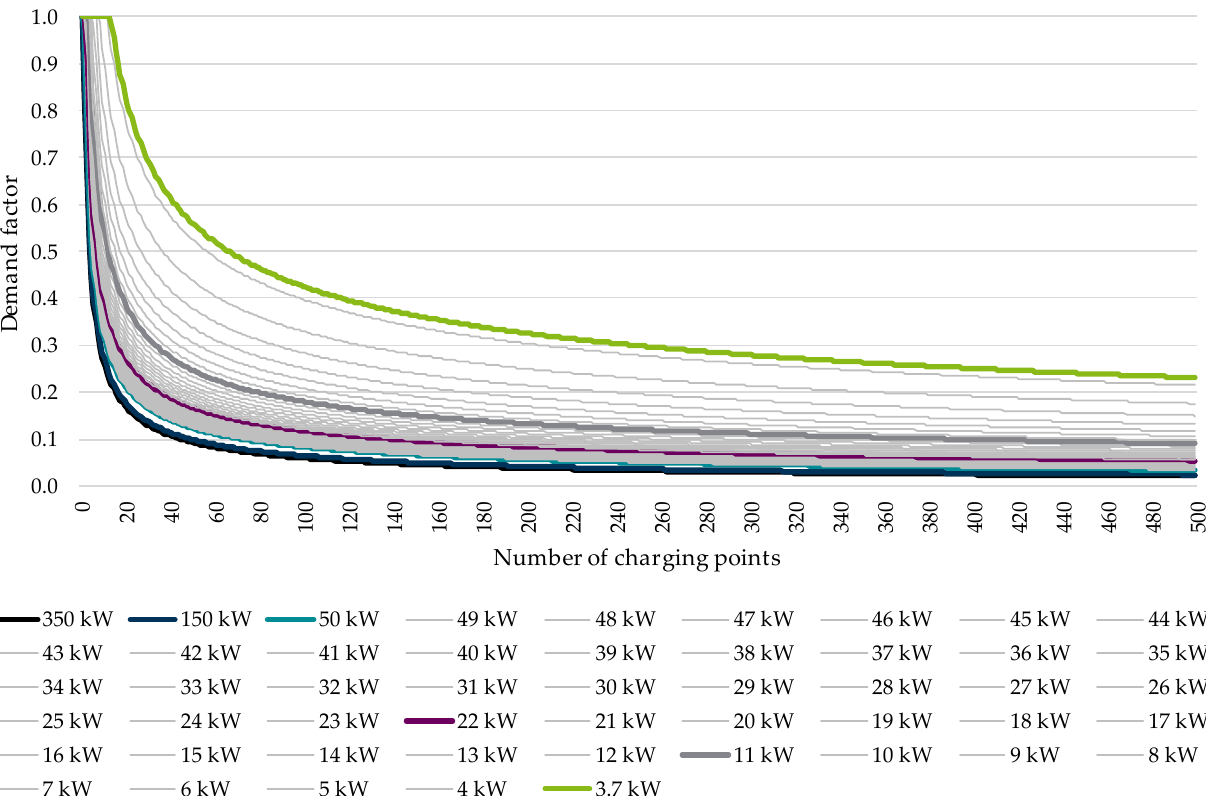
Region: Regiopolis, Large City”, Figure 13 for the area type “Urban Region: Medium-sized City, Urbanized Area”, Figure 14 for the area type “Urban Region: Small-town Area, Vil- lage Area”, Figure 15 for the area type “Rural Region: Central City”, Figure 16 for the area type “Rural Region: Medium-sized City, Urbanized Area” and Figure 17 for the area type “Rural Region: Small-town Area, Village Area”.